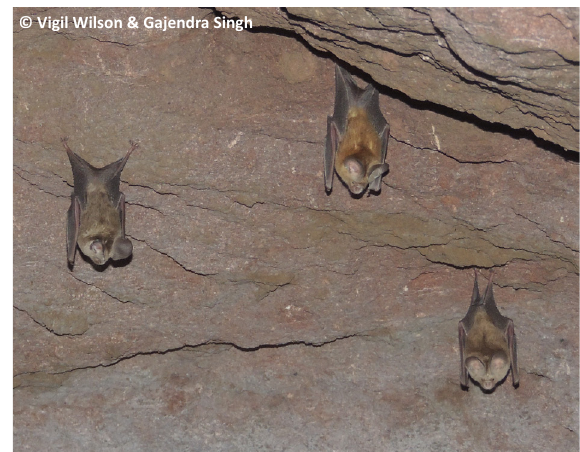
Image 4. Close-up from inside the